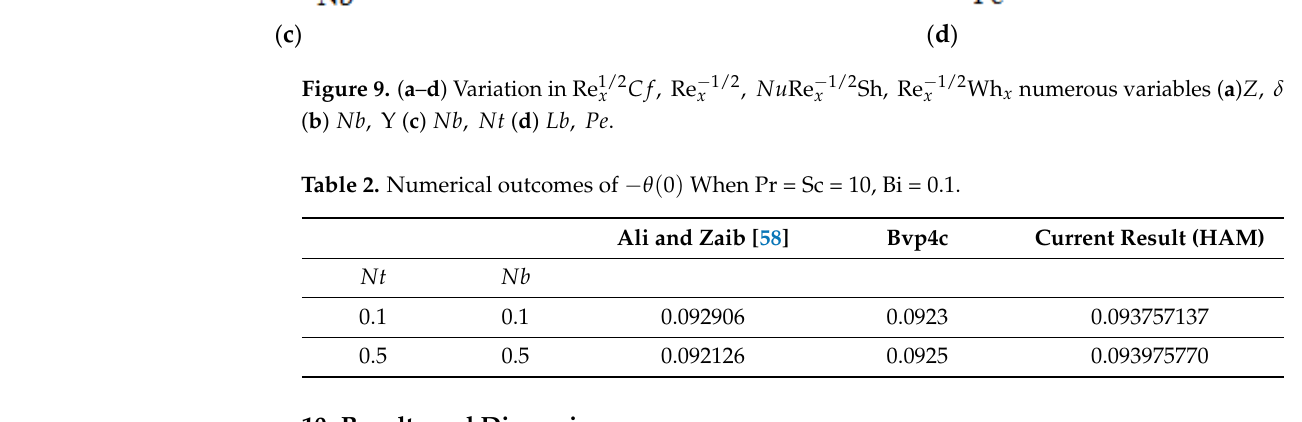
. Figure 3c manifests the effect of the enhanced power ‐ law index